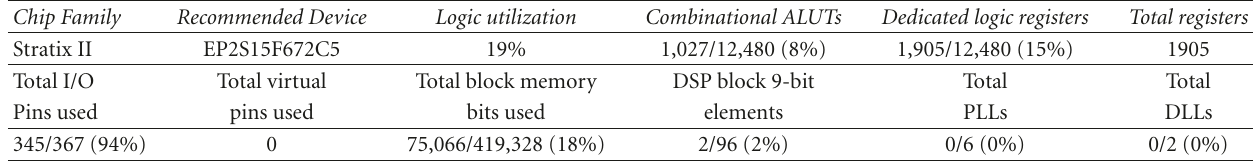
Table 7: Summarized resource utilization for real device and L m = 5, N = 64 and 2D STFT data length l = 8. Chip Family